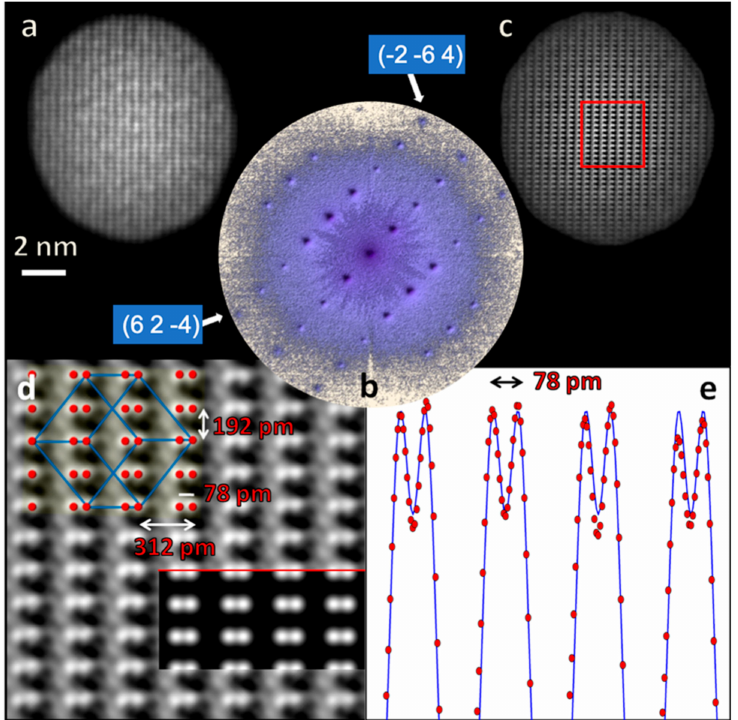
Figure 2. Keyhole electron diffraction imaging (KEDI) experiment on Si [112]: ( a ) HRTEM imaged of the self-confined illuminated area (support); ( b ) nanodiffraction pattern from the area shown in the HRTEM experiment in ( a ), the arrows point the diffracted spots at the highest frequency corresponding to a lattice spacing of 72 pm; ( c ) image reconstruction in the illuminated area after phase retrieval process; ( d ) magnified view of the image in ( c ) together with the atomic columns position within the Si crystal cell in [112] projection. The inset shows the simulation of the atomic projected potential in [112] projection; ( e ) simulated (dots) and measured (solid line) intensity profile of the Si atomic columns in [112] projection showing the Si dumbbell spacing at 78 pm well